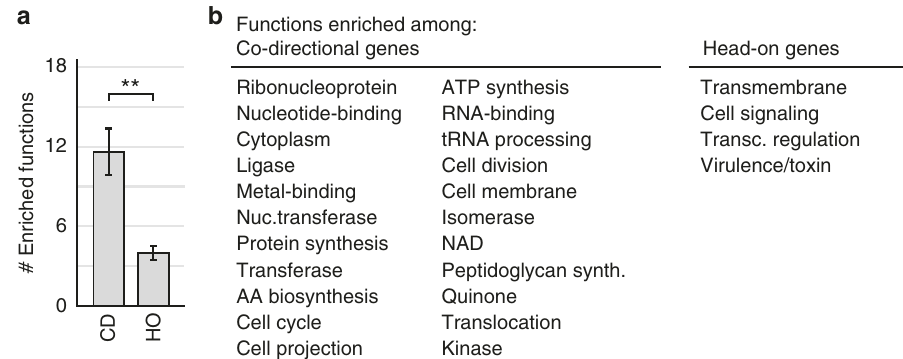
Fig. 6 Across phyla, HO genes are enriched in fewer and consistent functions. a The relative number of functions identi fi ed as enriched among co- directional (CD) vs. head-on (HO) genes is highly consistent across phyla. The number of functions found to be enriched among CD or HO genes was determined for 12 species (listed in the Methods section), then averaged across species. Error bars represent the standard error of the mean. Student ’ s t test was used calculate statistical signi fi cance, ** p value = 0.0004. b The functions of all lagging strand (head-on) or leading strand (co-directional) genes were determined on a per species basis. Functions found to be enriched in ≥ 4 organisms were included here as consensus